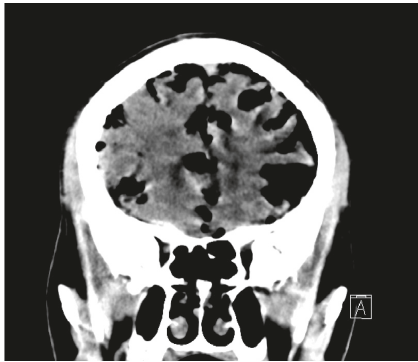
Figure 2: CT head with extensive pneumocephalus within the sulci and cisterns.